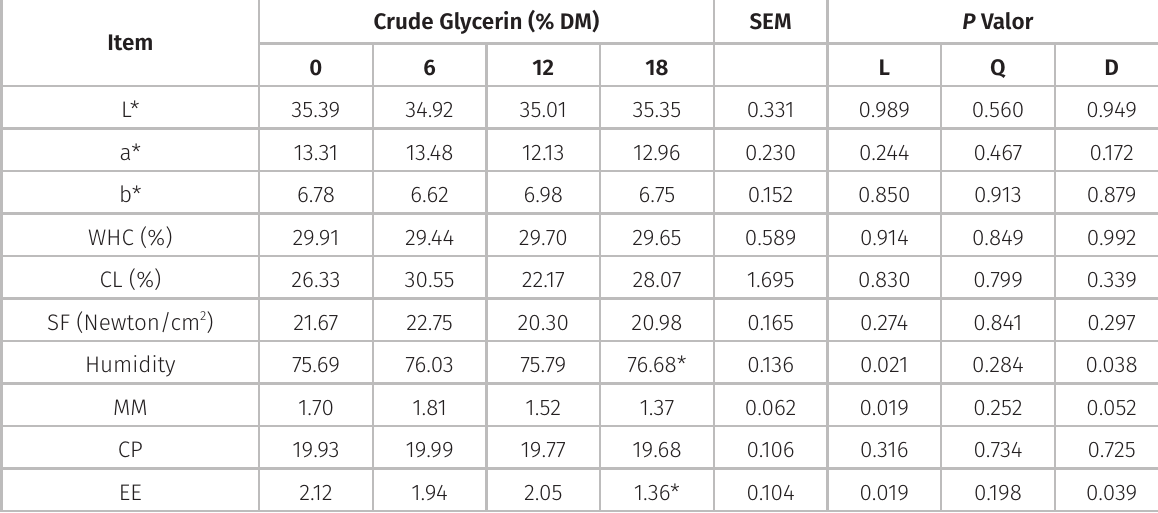
Table V. Physicochemical parameters of Longissimus lumborum muscle and chemical composition of Semimembranosus muscle of goats fed diets containing increasing levels of crude glycerin containing 63.06% glycerol and 45.57% lipids.